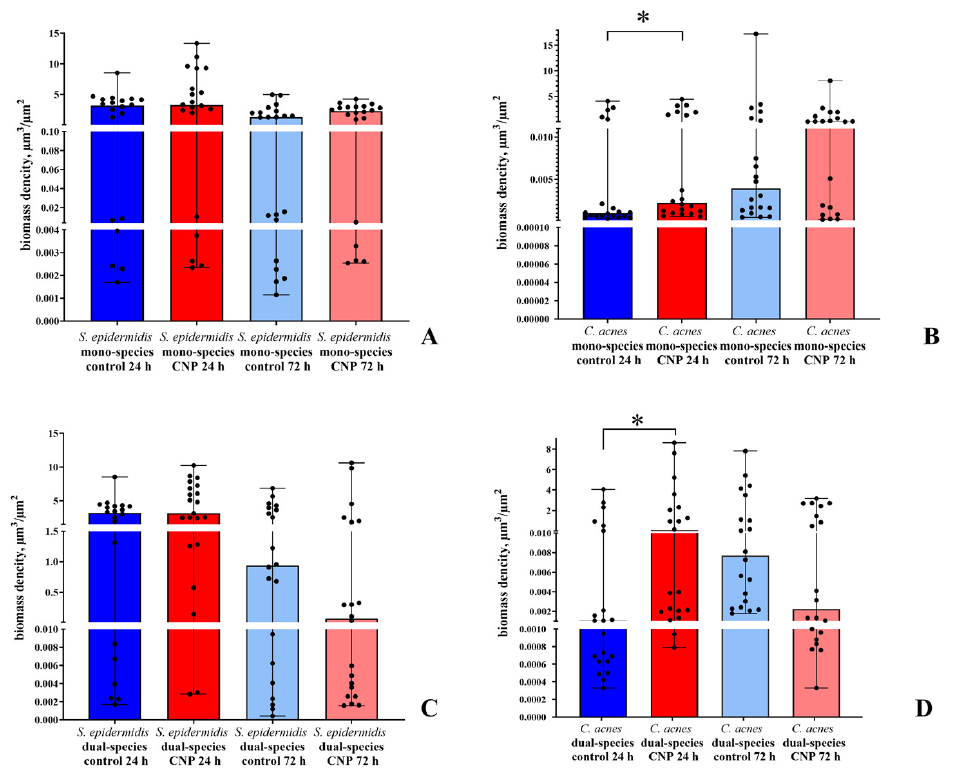
Figure 5. The analysis of CLSM images of mono-species and dual-species biofilms. ( A ), mono-species biofilms of S. epidermidis ; ( B ), mono-species biofilms of C. acnes ; ( C ), S. epidermidis proportion in dual-species biofilms; ( D ), C. acnes proportion in dual-species biofilms; * represents p < 0.05.